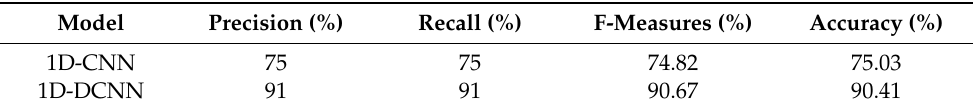
Table 4. Analysis of 1D-DCNN compare to 1D-CNN.